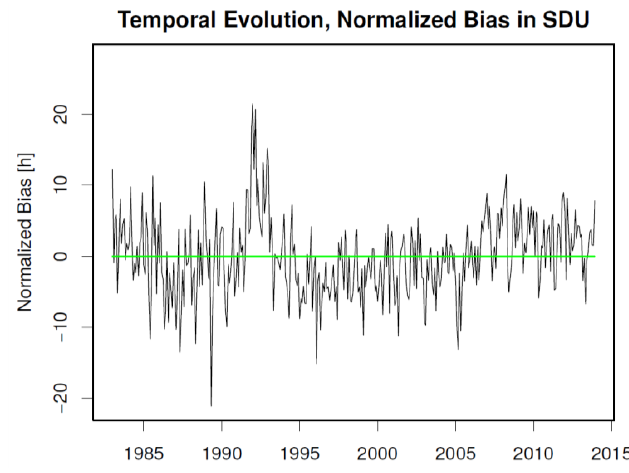
Figure 7. Temporal evolution of the normalized bias (h) between monthly SDU and CLIMAT for the time period 1983 to 2015. The normalized bias is the mean value for all stations.